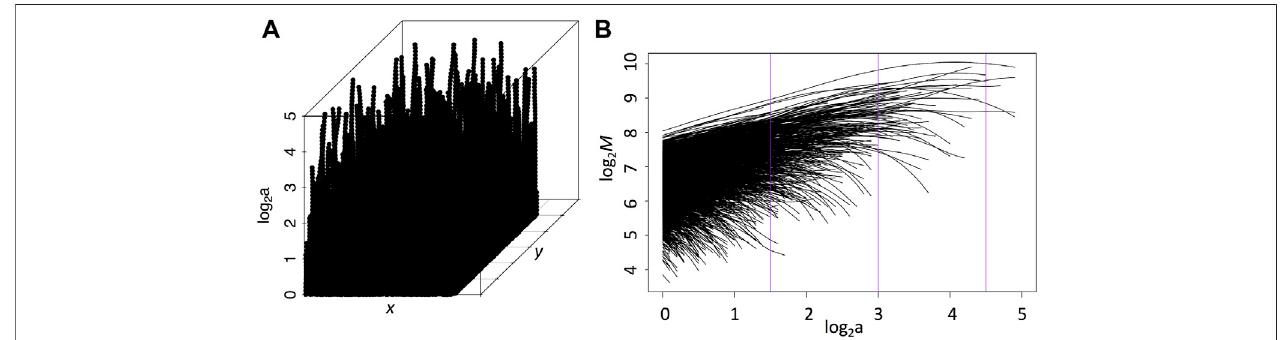
FIGURE3|(A) WTSkeleton:eachverticallineconnectingtheWTMMMthroughthescales,bylinkingtheWTMMMclosestatthenextscale,isknownasamaxima line. Each WTMMM point along these maxima lines have a modulus value at each ( x , y , log 2 ( a )) position. (B) Sheaf: One can study the behavior of the modulus as a function of the scale parameter for each maxima line by eliminating the positional information (see Eq. 3 ). The three vertical purple lines correspond to scales 20, 56, 158 pixels represented in Figures 2B – D . In these two plots, the scale parameter is expressed in units of 7*2 a pixels.